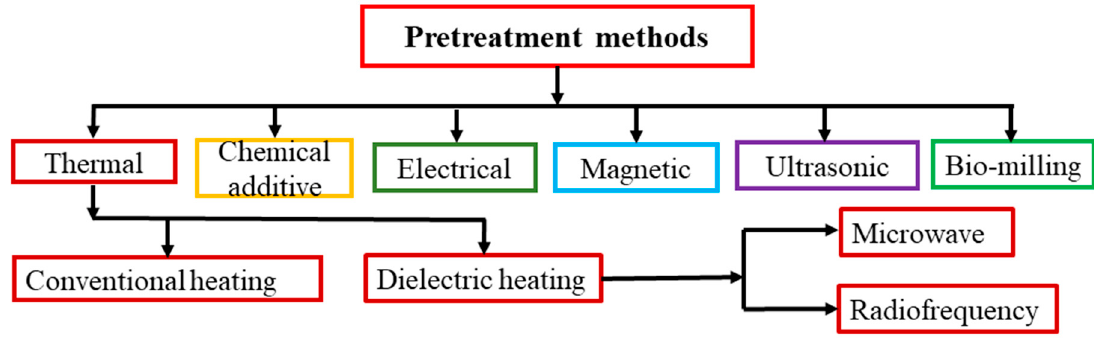
Figure 3. Classification of pretreatment methods.